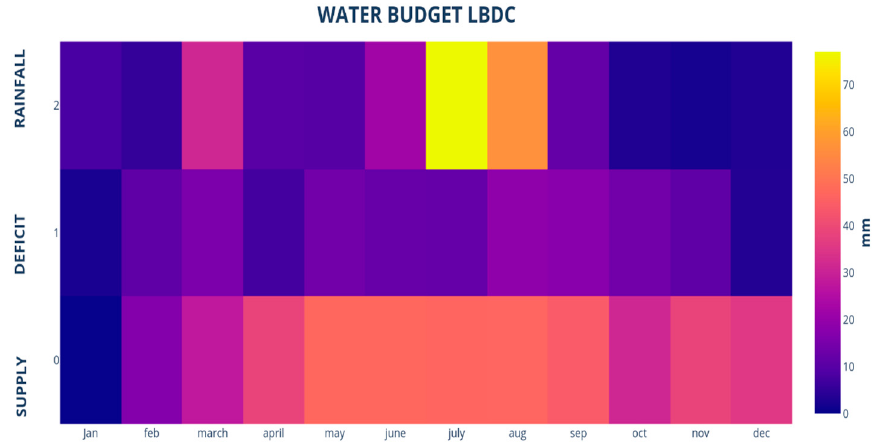
Figure 17. Crop water balance heat map for year 2016 (developed in R-Studio).